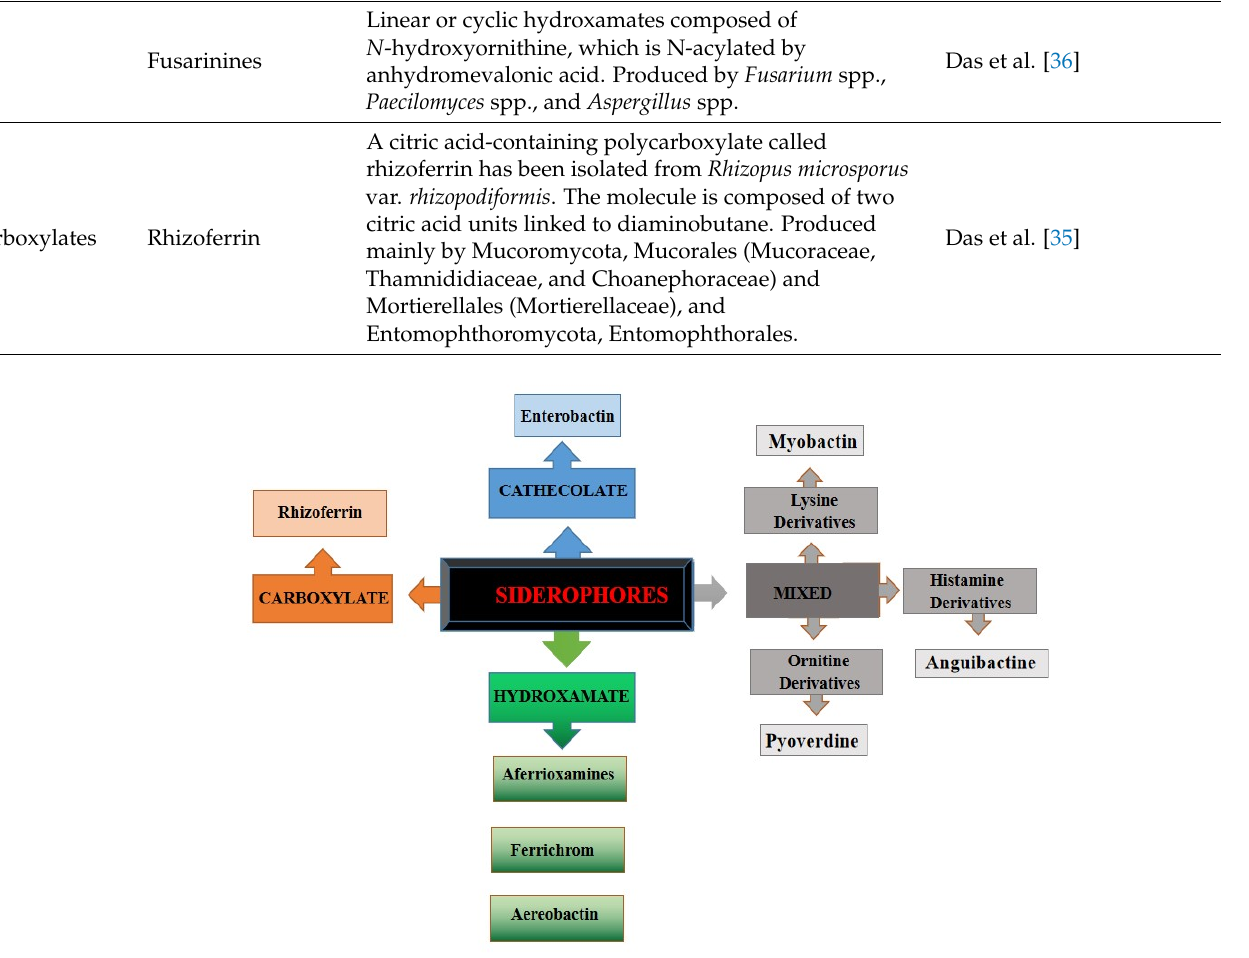
Figure 1. General groups of siderophores. Table 1. Types of siderophores and their characteristics.